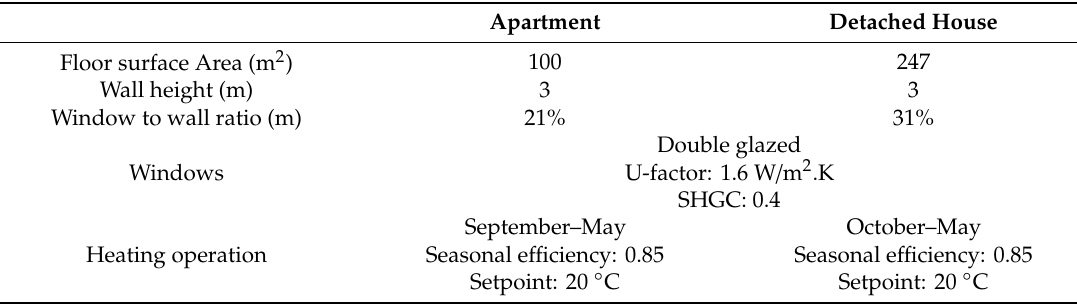
Table 1. Characteristics of the modeled apartment and detached